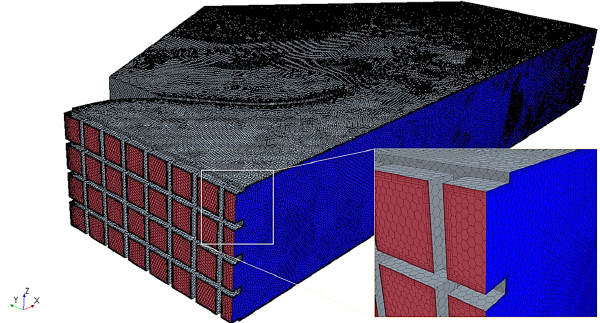
Figure 5. The M2 grid for the V-c